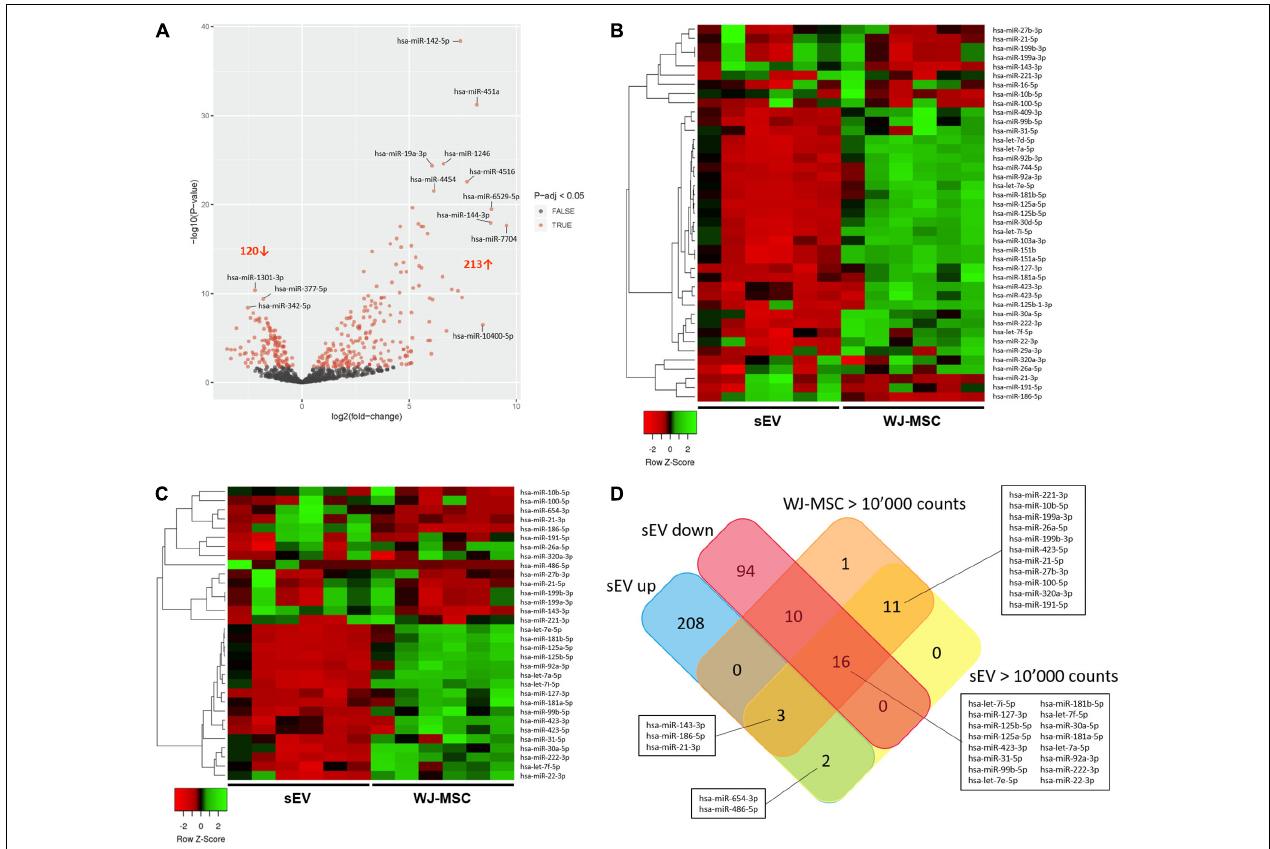
FIGURE 4 | Characterization of miR expressed in WJ-MSC and their derived sEV by Illumina HiSeq Sequencing. (A) Volcano plot illustrating miR expression in sEV relative to WJ-MSC. (B) Heatmap showing the most prevalent miR expressed in WJ-MSC (mean normalized counts > 10,000) relative to sEV. (C) Heatmap showing the most prevalent miR expressed in sEV (mean normalized counts > 10,000) relative to WJ-MSC. (D) Venn plot summarizing the datasets of miR, which were significantly up-regulated in sEV (EV up) compared to WJ-MSC, significantly down-regulated in sEV (EV down) relative to WJ-MSC, and highly abundant in sEV (EV > 10,000 counts) and WJ-MSC (WJ-MSC > 10,000